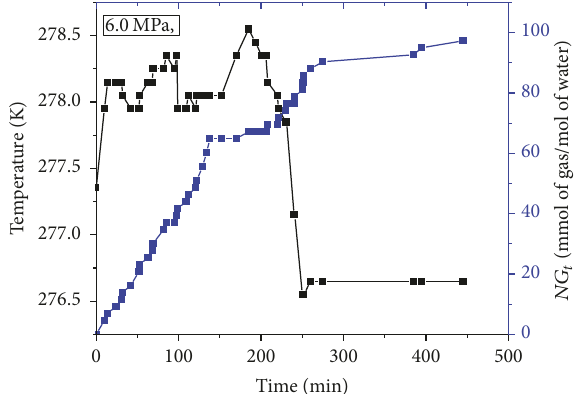
Figure 3: Hydrate formation in pure water at 6.0 MPa.